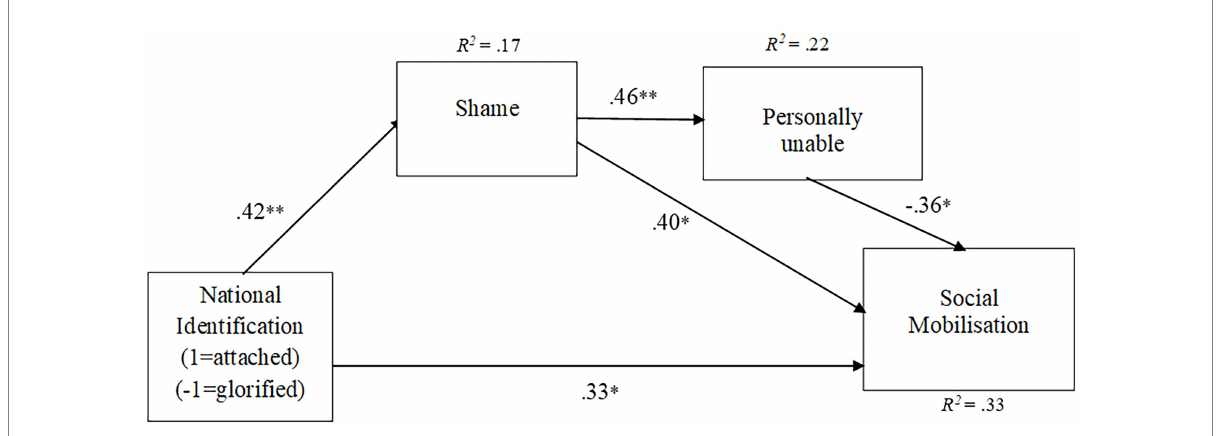
FIGURE 1 Structural regression model of the relationship between national identification and social mobilization. Solid lines represent statistically significant paths, * p < 0.01 and ** p < 0.001.